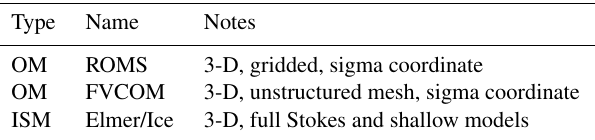
Table 1. Ice and ocean components currently coupled through